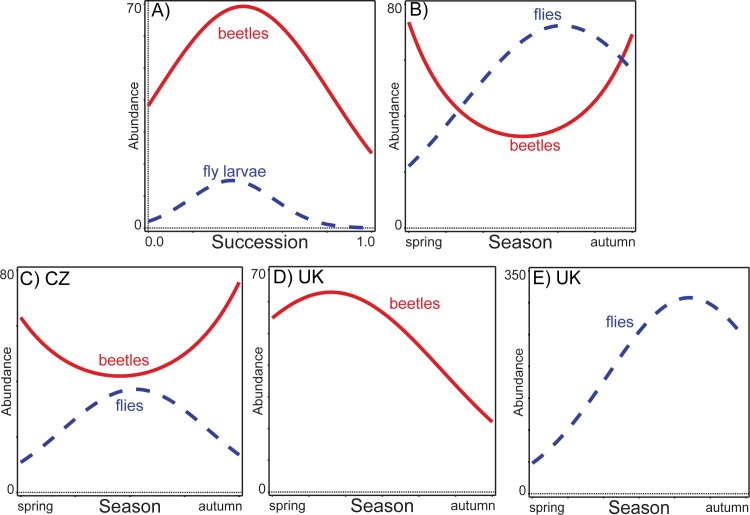
Trends of dung-inhabiting beetle and fly abundances during succession (Czech Republic) and season (both sites).A) successional trends of dung-inhabiting beetles (solid red line) and fly larvae (dashed blue line) (data from the Czech Republic), B) seasonal trends of dung-inhabiting beetles (solid red line) and flies (dashed blue line) (data from both sites), C) seasonal trends of dung-inhabiting beetles (solid red line) and flies (data from the Czech Republic), D) seasonal trends of dung-inhabiting beetles (data from the United Kingdom), E) seasonal trends of dung-inhabiting flies (data from the United Kingdom),